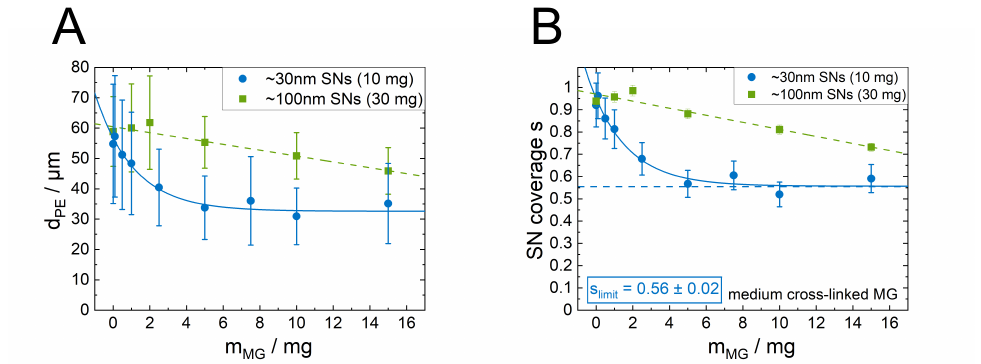
Figure 6. Comparison between emulsions stabilized with smaller and larger SNs, respectively, with increasing amount of the medium cross-linked MGs ( V PE,tot = 12.55 mL, 20 vol%, oil type 1-dodecene). The SN mass was adjusted so that both applied particle systems exhibit the same total particle cross section A ∅ . ( A ) The Sauter mean droplet diameter decreases in both cases with the present amount of MGs. A saturation behavior is only clearly visible in the case of the smaller SNs. ( B ) The calculations of the SN coverage parameter s shows that while the fraction of interface covered by the larger SNs decreases with the increasing present amount of MG, it never passes the minimum coverage parameters s limit of around 0.56 calculated for the smaller